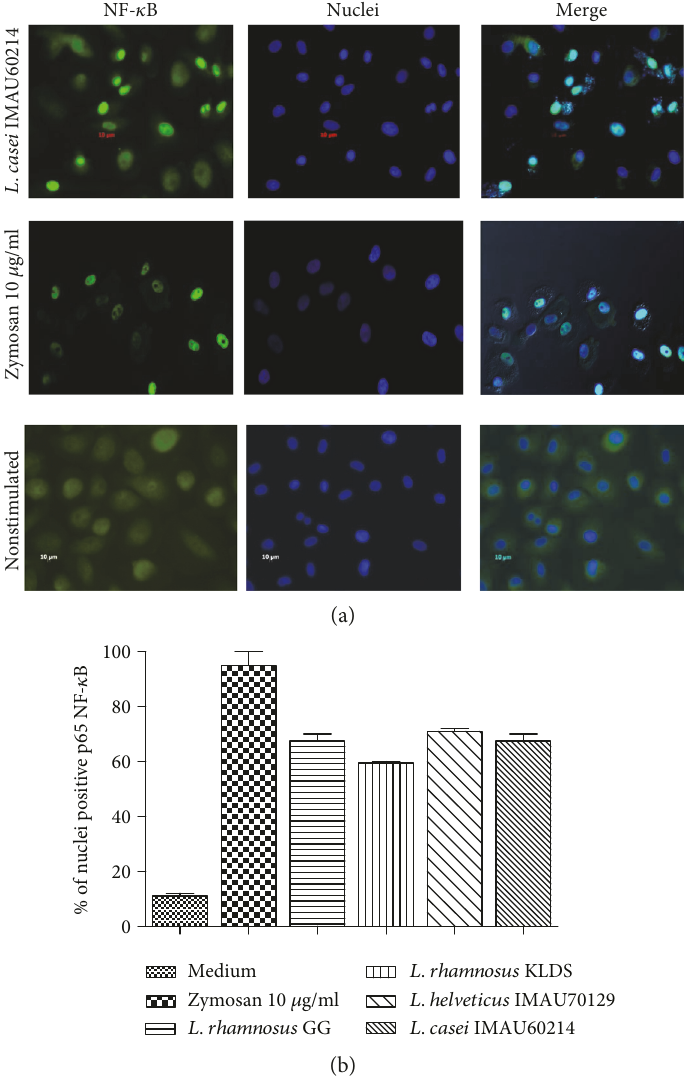
Figure 5: Immuno fl uorescence analysis of NF- k B activation. Human macrophages were stimulated for 30min with heat-killed lactobacillus at a MOI of 1 :500, zymosan (positive control) or left unstimulated. (a) Nuclear translocation was de fi ned as blue fl uorescence (Hoechst staining), and the NF- k B pp65 subunit was identi fi ed using green fl uorescence (Dylight 488). (b) The percentage of nuclei that were positive for pp65. The results represent three independent